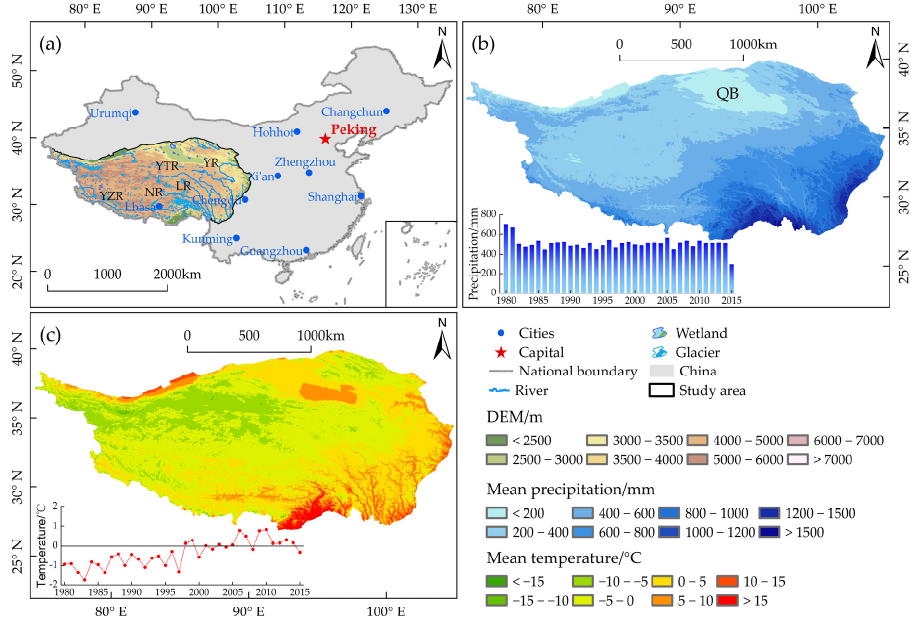
Figure 1. Main environmental characteristics of the TP: ( a ) geographical location, topography and river system of the study area, ( b ) spatiotemporal variation characteristics of precipitation in the study area from 1985 to 2015, ( c ) spatiotemporal variation characteristics of mean temperature in the study area from 1985 to 2015. River name abbreviations: LR-Lancang; NR-Nujiang; YR-Yellow; YTR-Yangtze; YZR-Yarlung Zangbo.